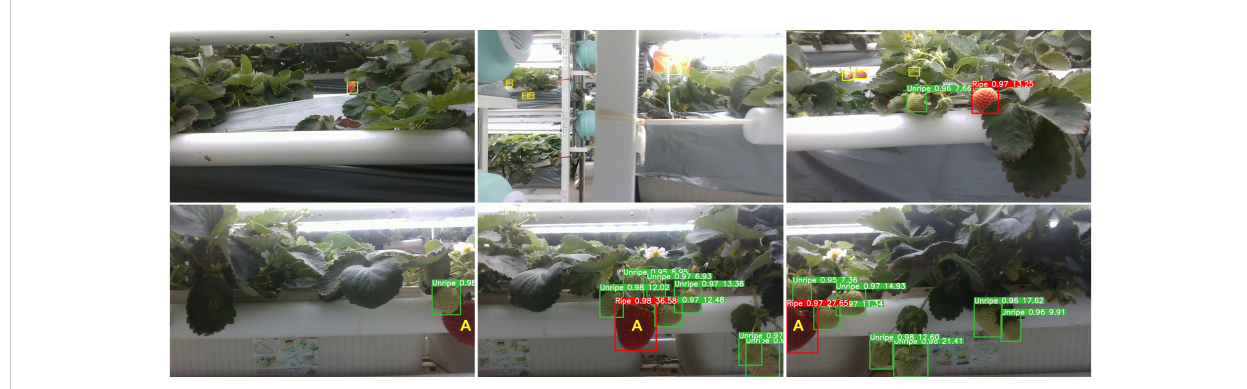
FIGURE 6 Upper row: Three example cases that needed to be processed by distance fi ltration. Strawberries annotated with yellow bboxes were not in the experimental areas and were not counted. Bottom row: Edge fi ltration was applied to process three consecutive keyframes ( r = 2). The ripe fruit A was not counted since it was partly visible on the right edge of the left image. Fruit A was counted after it had moved to the left edge of the right